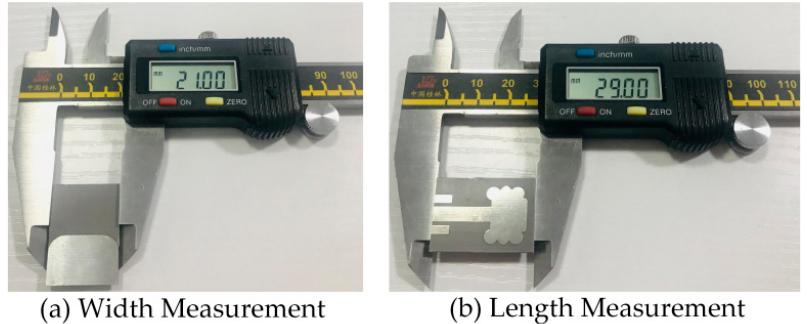
Figure 6. Manufactured antenna prototype: ( a ) back view and ( b ) front view.